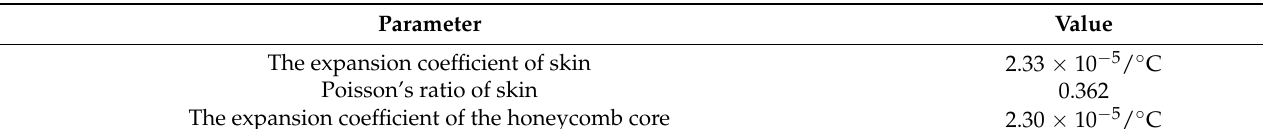
Table 10. Model correction parameters under in-orbit simulation temperature.